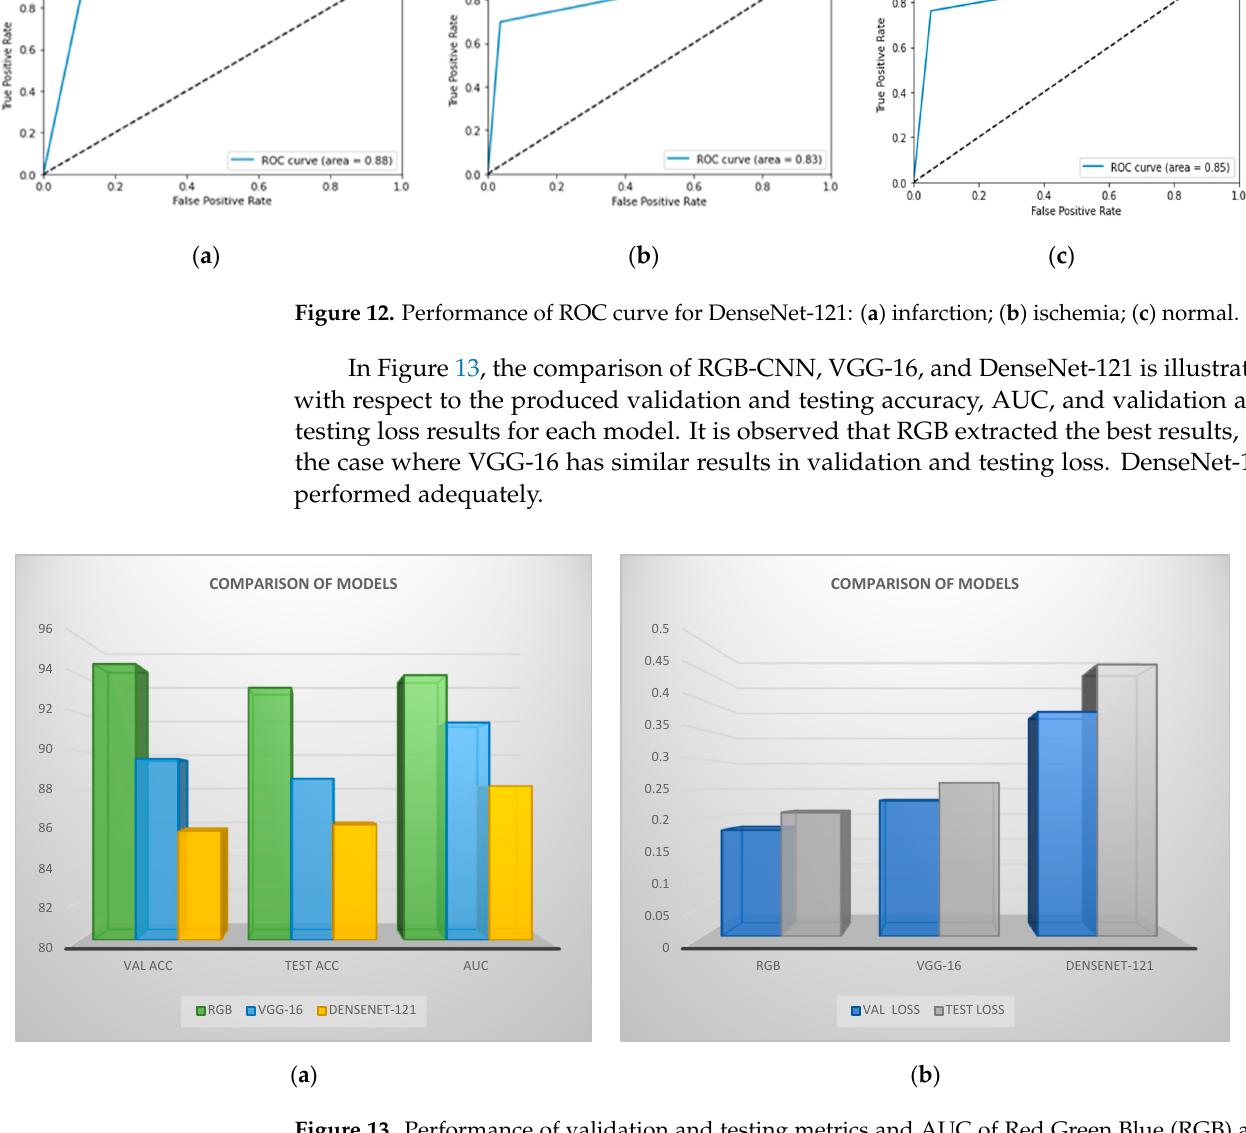
Figure 13. Performance of validation and testing metrics and AUC of Red Green Blue (RGB) and transfer learning: ( a ) accuracies; ( b ) losses. ACC is the accuracy and VAL the validation.